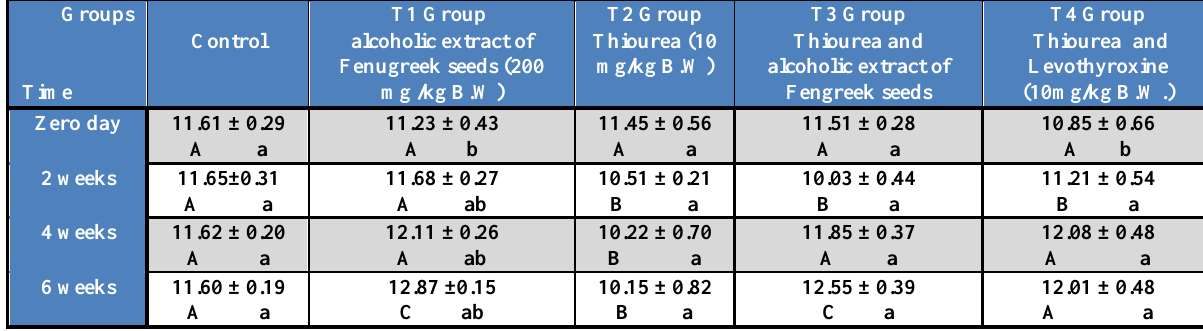
Different small letters means significant (P ≤ 0.05) results between groups. Different capital letters means significant (P ≤ 0.05) results between